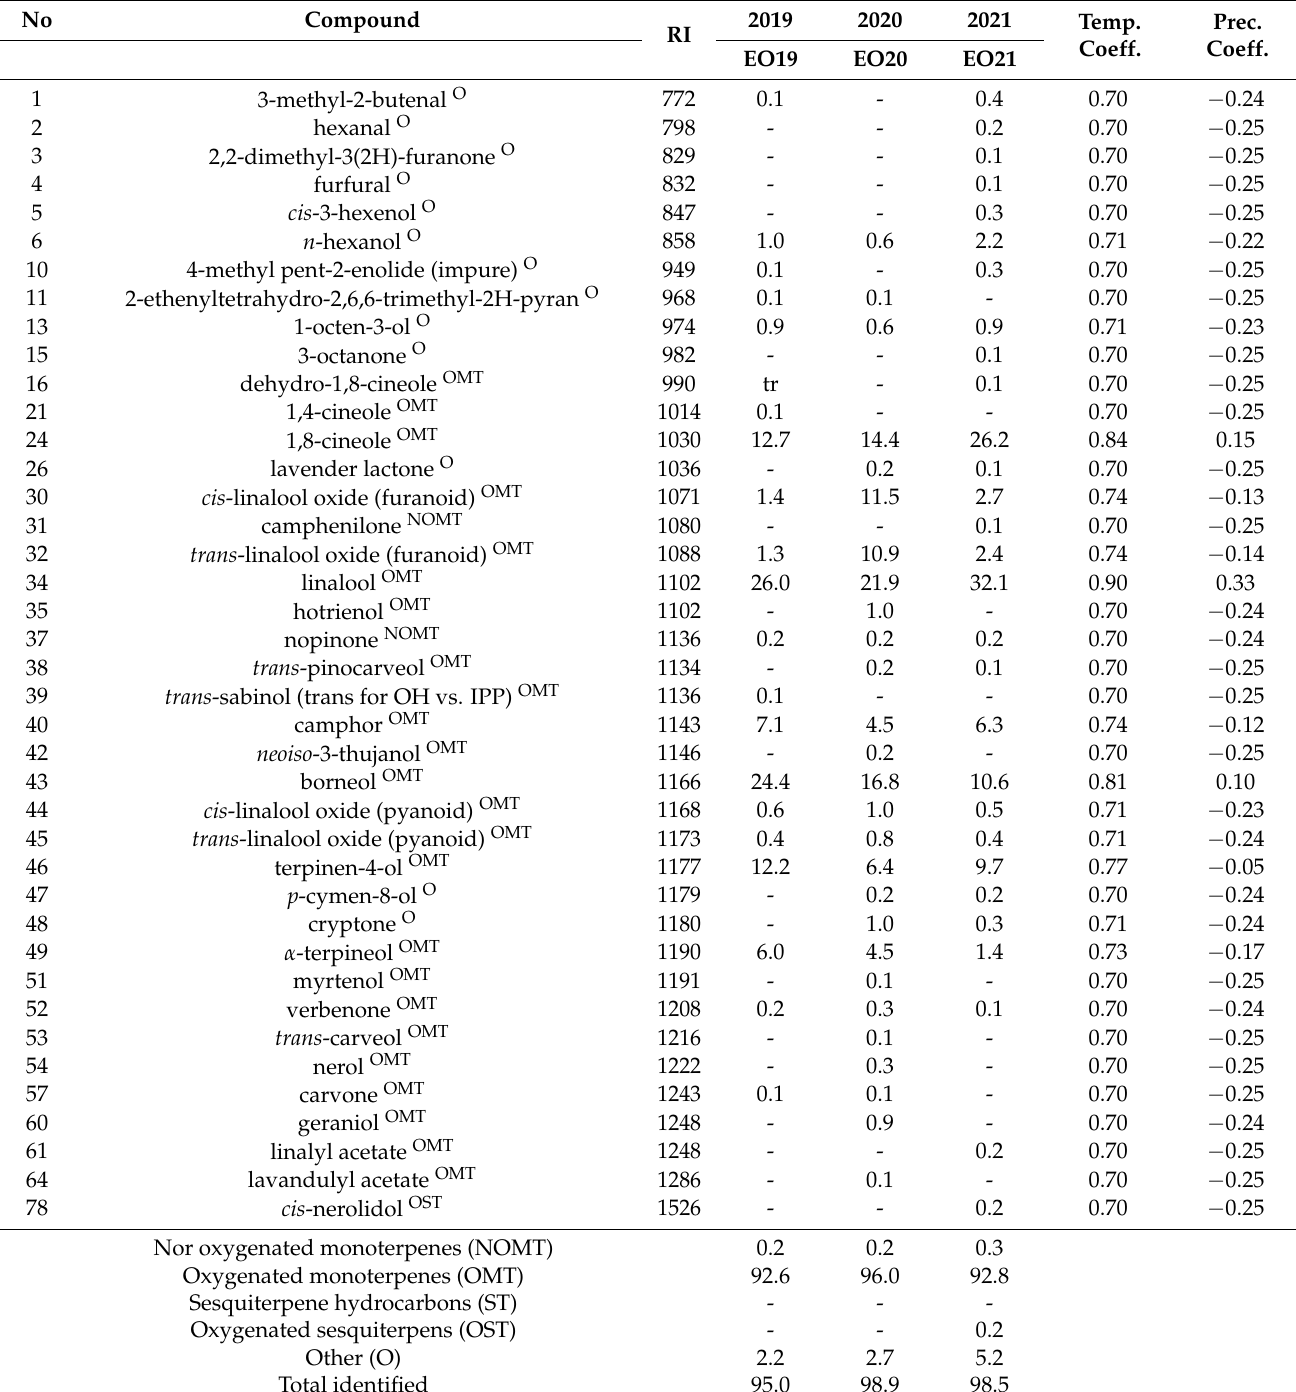
Table 4. L. x intermedia cv. ‘Budrovka’ hydrolate composition during three growing years and related multiple correlation coefficients with the observed temperature and precipitation